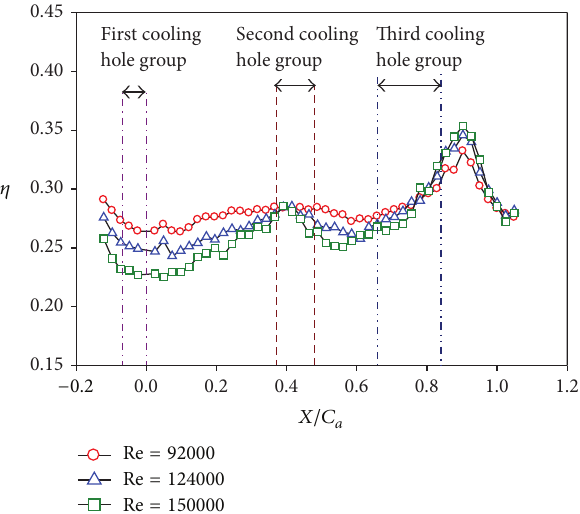
Figure 9: Effect of Reynolds number at low turbulence intensity ( 𝑆/𝐶 = 0 %, 𝑀 = 1 , and T . I . = 1.8 %).